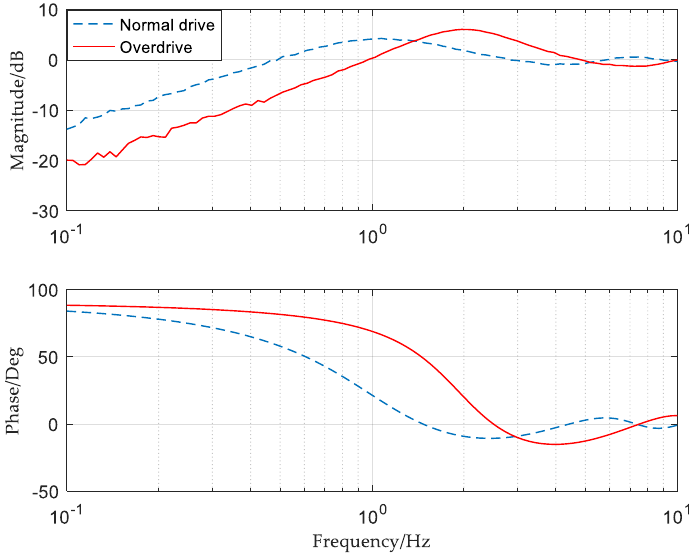
Figure 10. Characteristics of error suppression under different driving conditions.